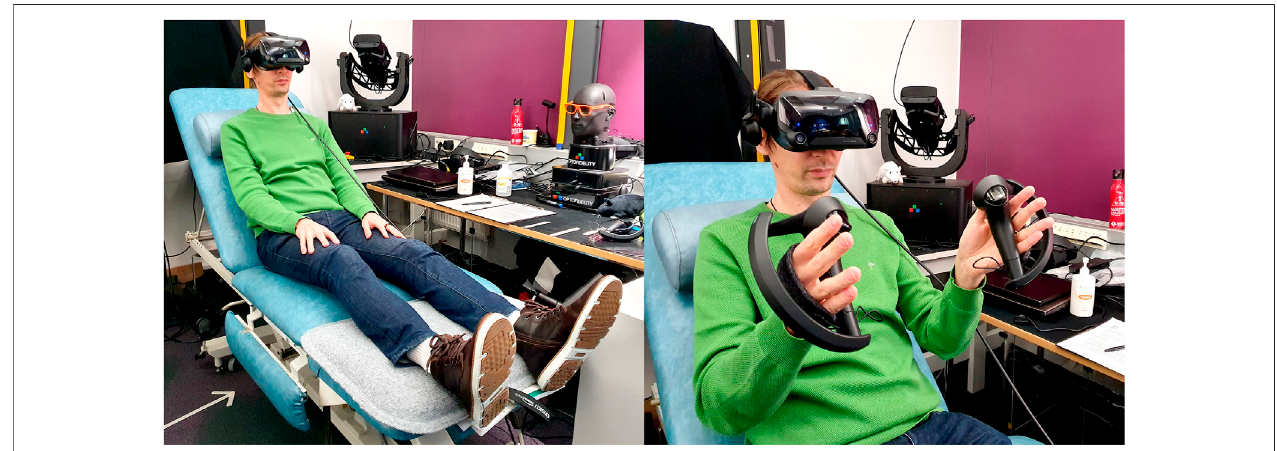
FIGURE 3 | Participants were resting on an exam table during synchronous and asynchronous visuo-tactile conditions (left) and using VR controllers to estimate cube sizes (right).